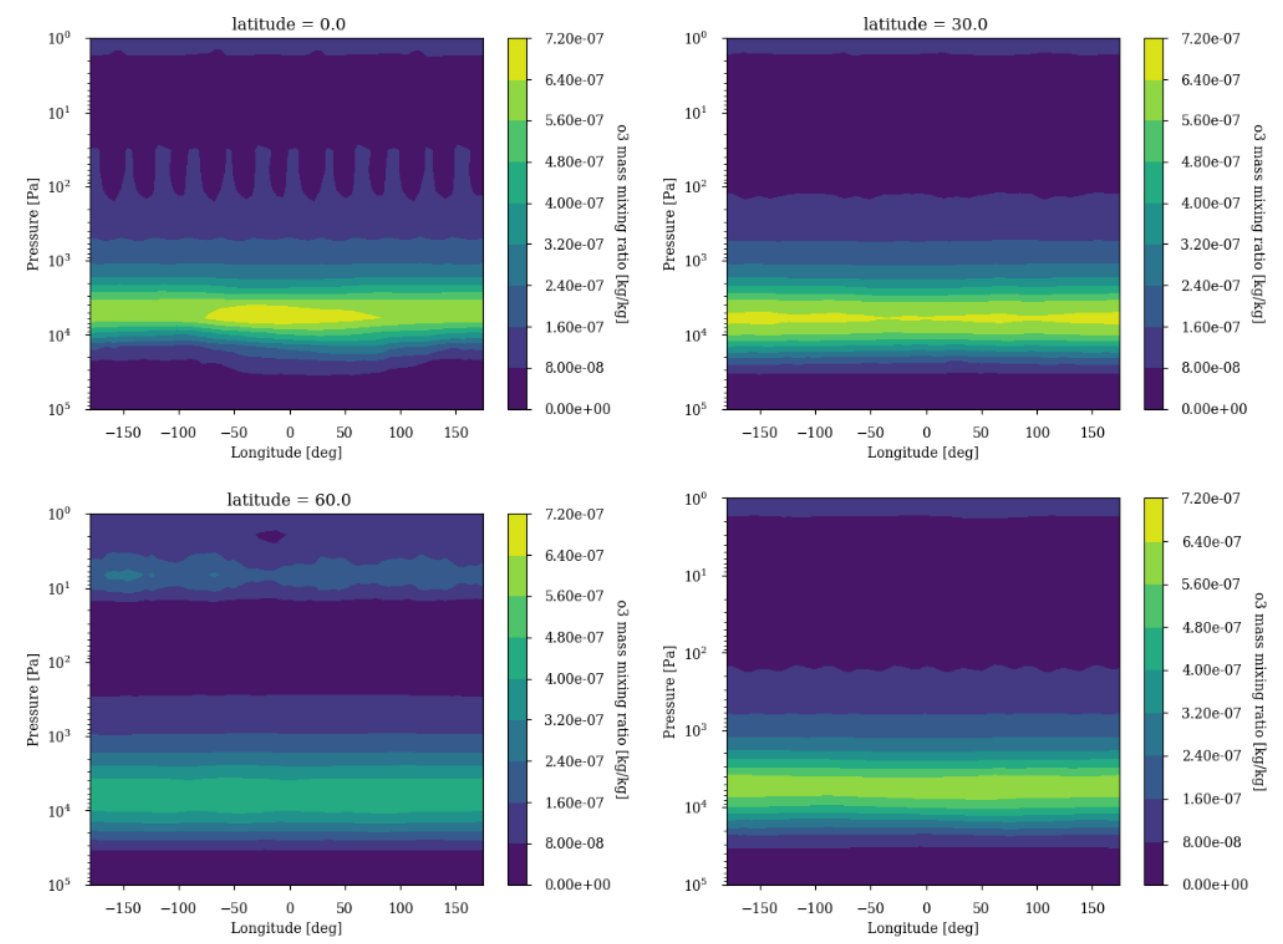
Figure 7. Ozone annual average longitudinal profile for latitudes 0, 30 and 60 ◦ as well as the latitudinal average. Surface: CH 4 = 10 − 4 and O 2 = 10 − 3 .